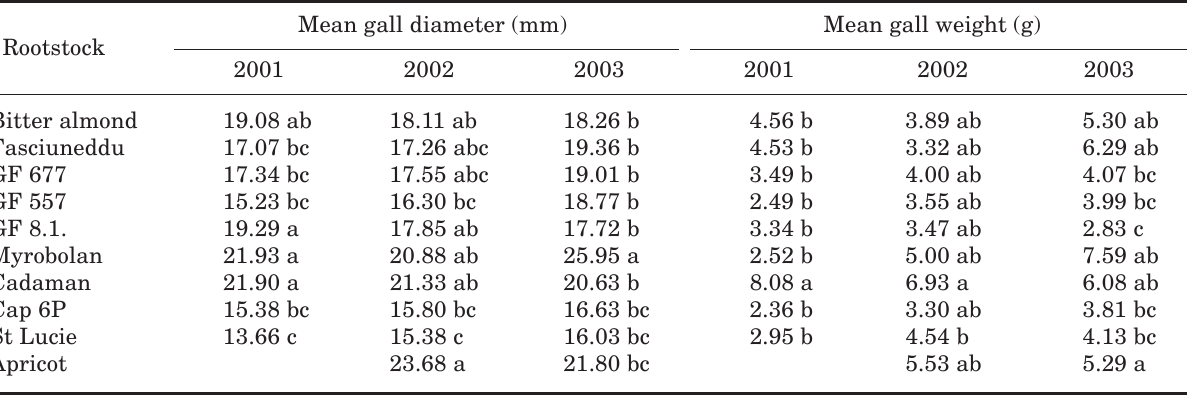
Table 5. Mean gall diameter and weight after growing in Agrobacterium tumefaciens contaminated